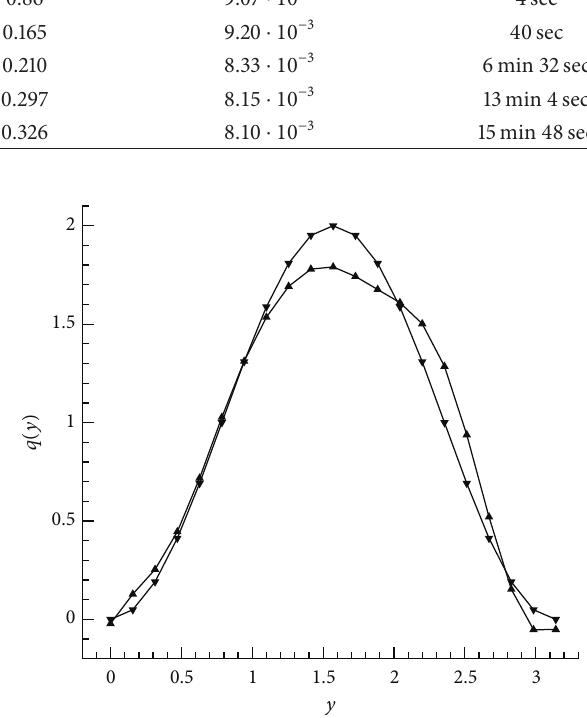
Figure 3: 󳶃 indicates exact solution 𝑞(𝑦) ; 󳵳 indicates solution obtained by the Godunov